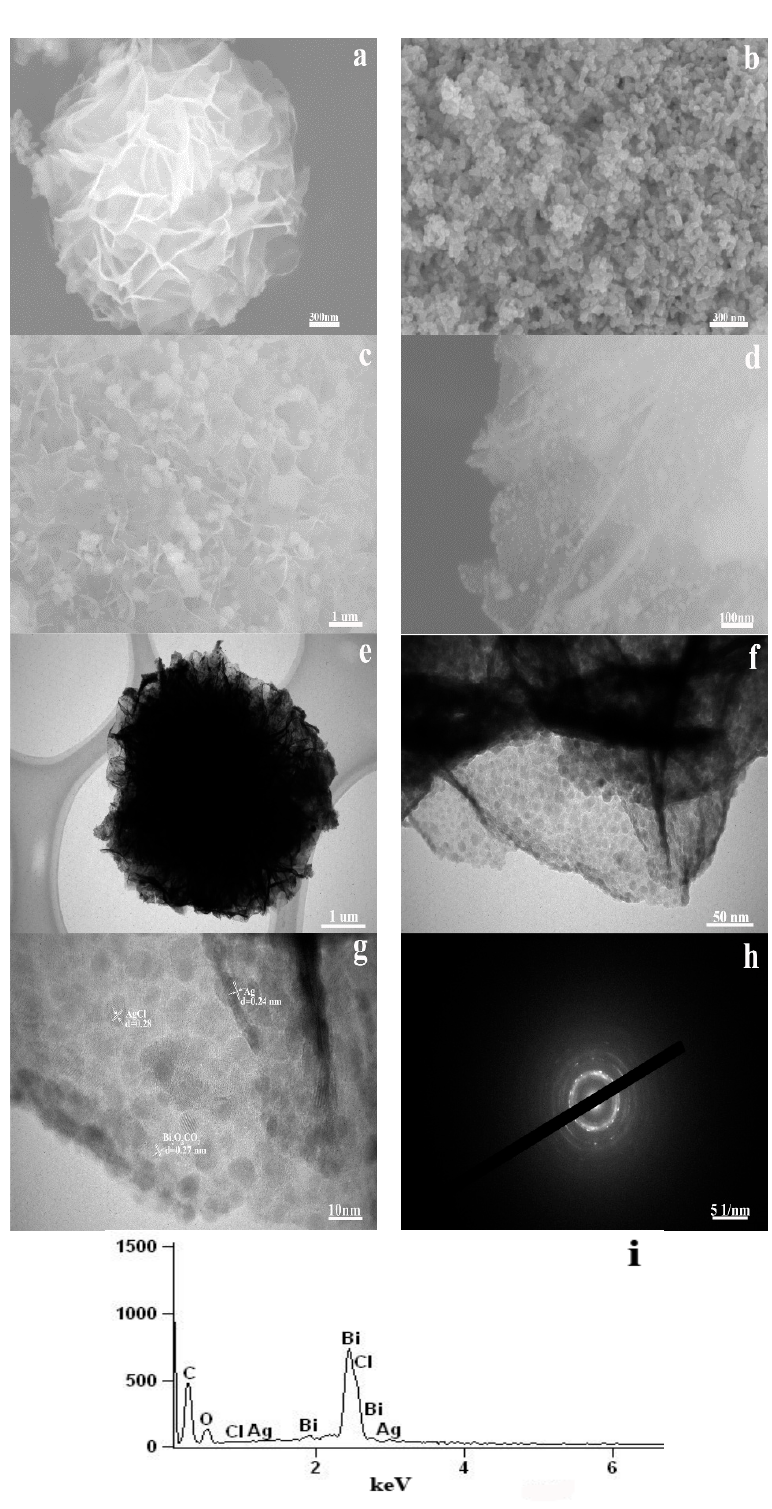
Figure 3. SEM images of: ( a ) Bi 2 O 2 CO 3 ; ( b ) Ag@AgCl; ( c ) P-Ag@AgCl/Bi 2 O 2 CO 3 ; and ( d ) Ag@AgCl/Bi 2 O 2 CO 3 . TEM images of ( e , f ) Ag@AgCl/Bi 2 O 2 CO 3 . HRTEM and SAED images of ( g , h ) Ag@AgCl/Bi 2 O 2 CO 3 . EDX spectrum of ( i ) Ag@AgCl/Bi 2 O 2 CO 3 samples.